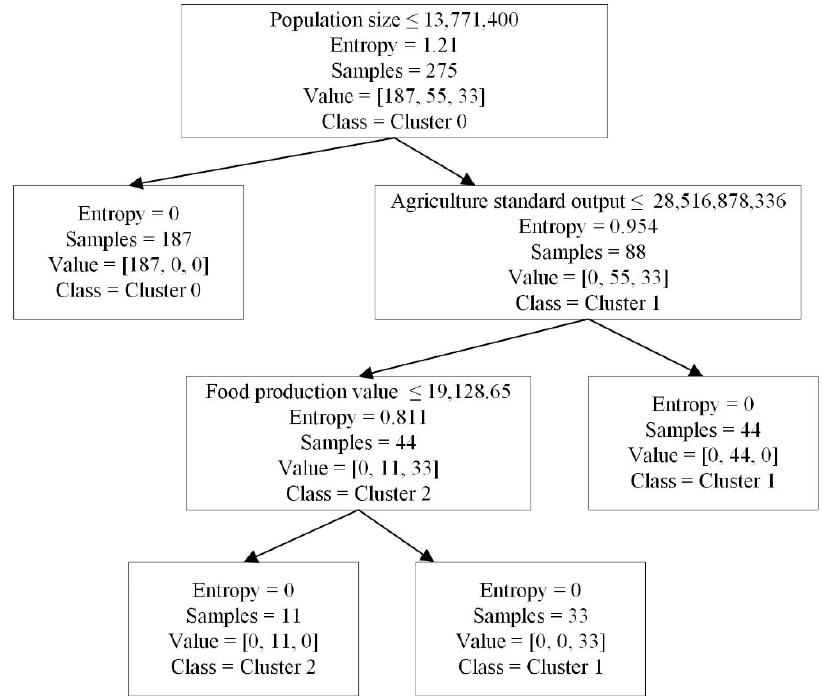
Figure 6. Decision tree of cluster assignment, created by authors.